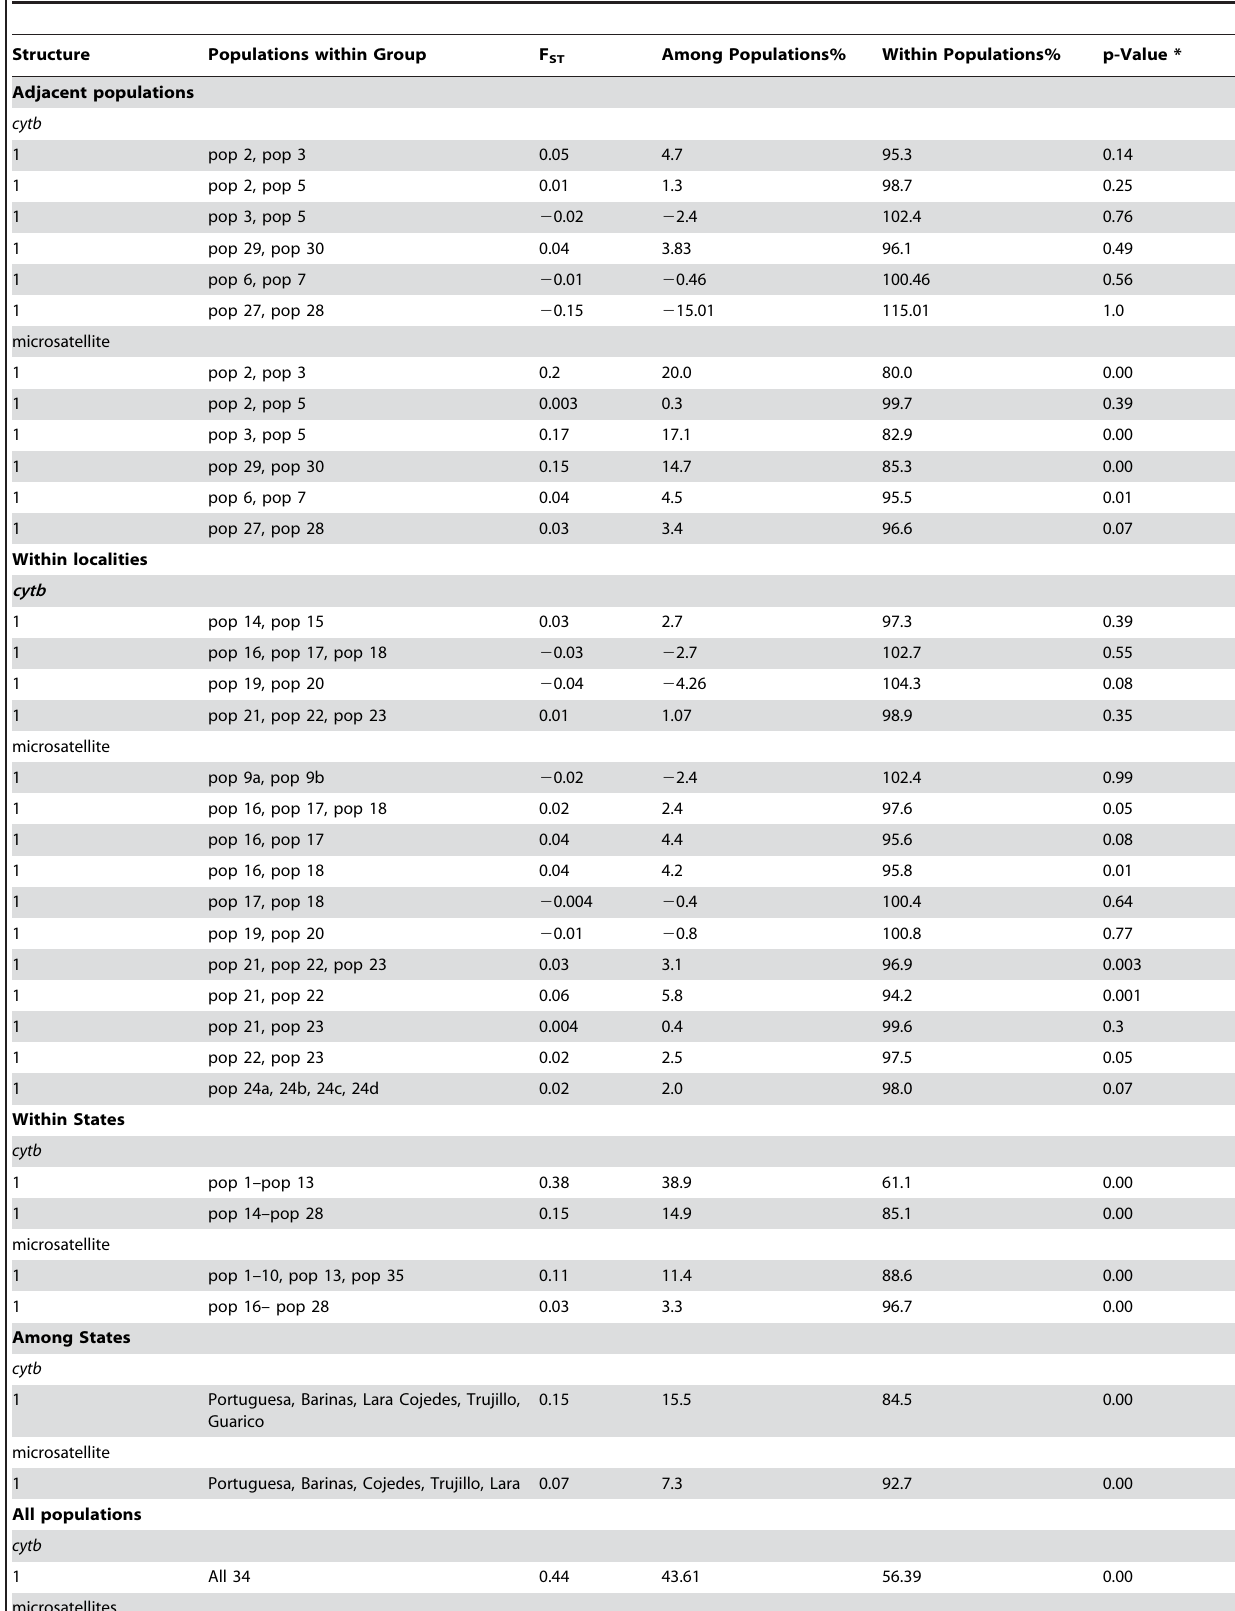
Table 3. Results of hierarchical analysis (AMOVA) of population.